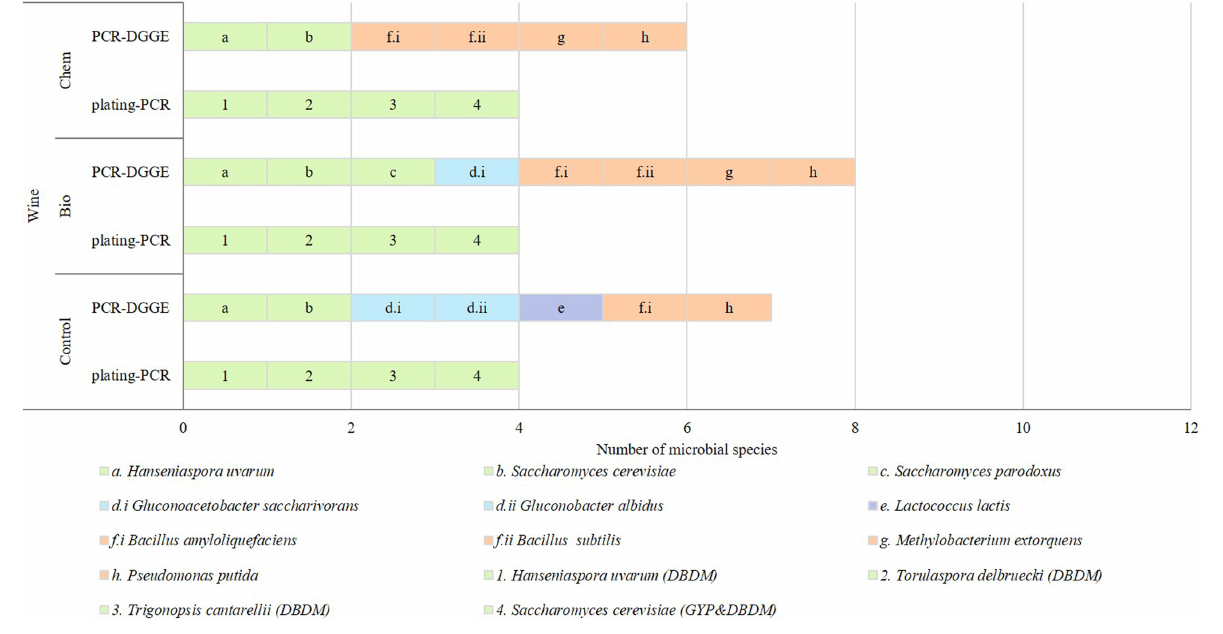
FIGURE 4 | Microbial species detected in wine samples (C: control, Bio: bio-fungicide, and Chem: chemical fungicide) from GYP and DBDM plates referred to as letters and by PCR-DGGE referred to as numbers. Green slices identified eukaryotic species; blue slices were AAB; purple slices were LAB; and orange slices